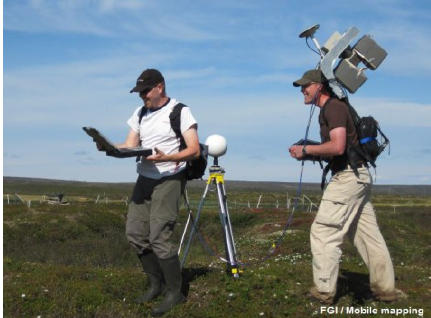
Figure 6. Mapping of permafrost palsa landforms in Finnish Lapland with Akhka backpack mobile laser scanning unit.